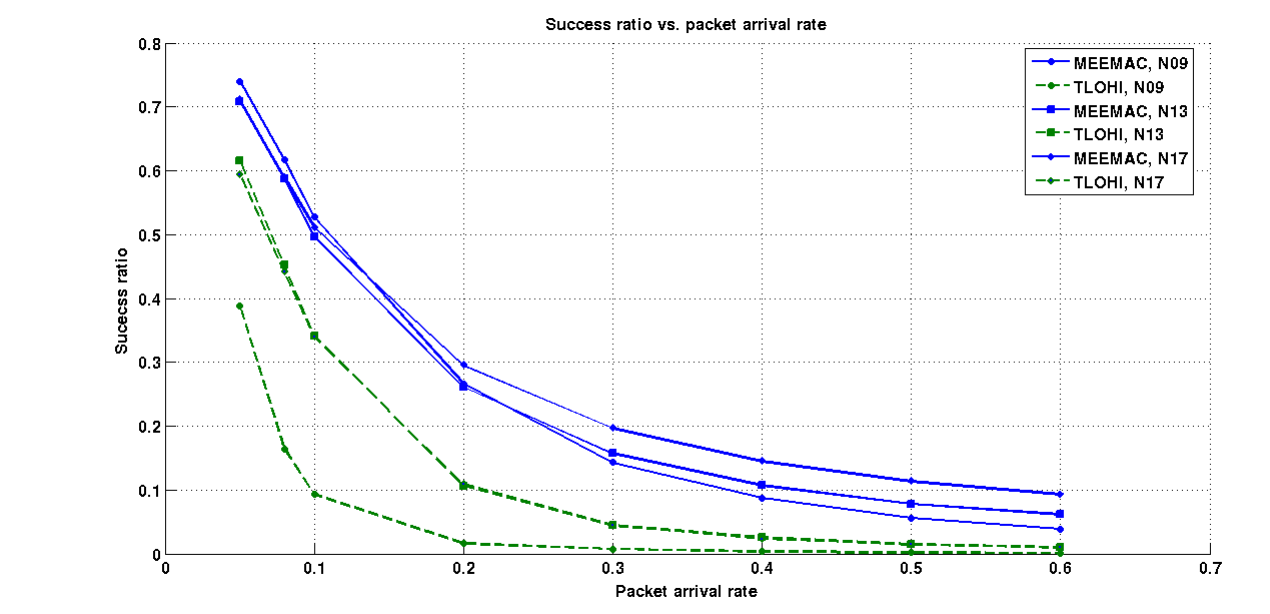
Figure 16. Success ratio (success probability) vs. the arrival rate for a multi-hop